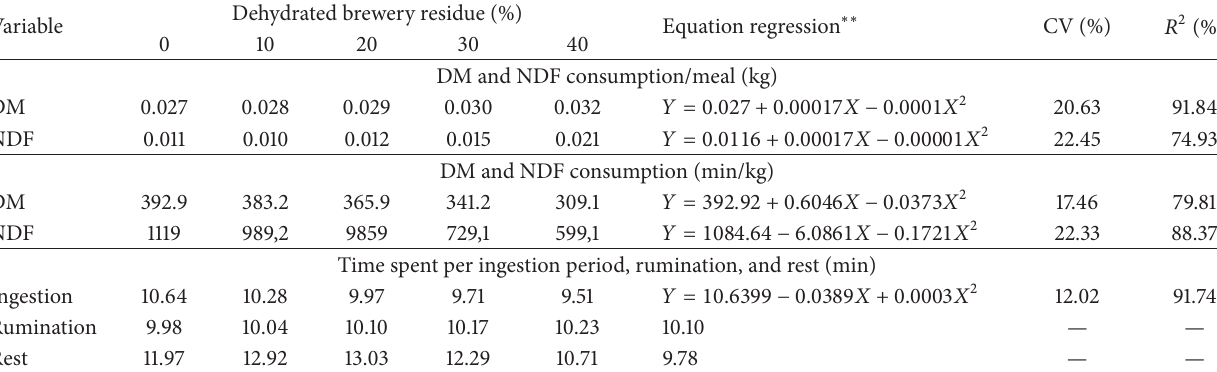
Table 4: Neutral detergent fiber (min/kg) and time spent per ingestion period, rumination, and rest (min) of ovine fed with marandu grass silage.